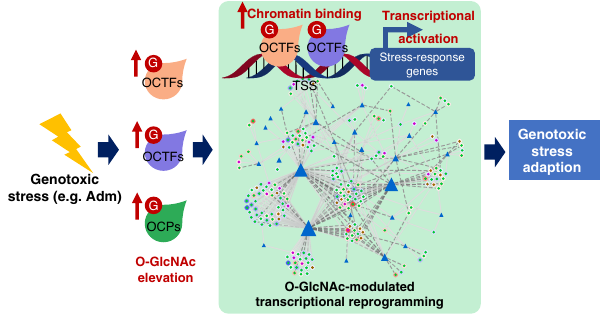
Fig. 9 Proposed model for the genotoxic stress-responsive transcriptional reprogramming orchestrated by multiple OCTFs in breast cancer cells. Genotoxicity provokes O-GlcNAc (G) elevation and dynamic changes in multiple OCTF genomic binding sites. The activity of multiple OCTFs, including NRF1, modulates a network of transcriptome upregulation to induce a holistic effect on cell fates in response to